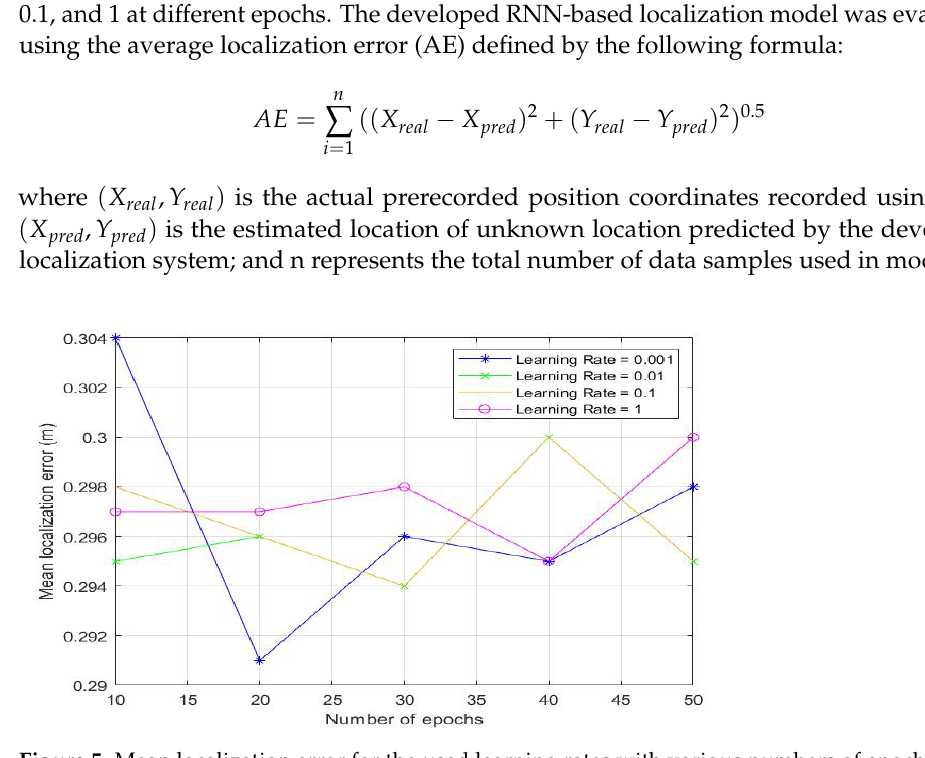
Figure 5. Mean localization error for the used learning rates with various numbers of